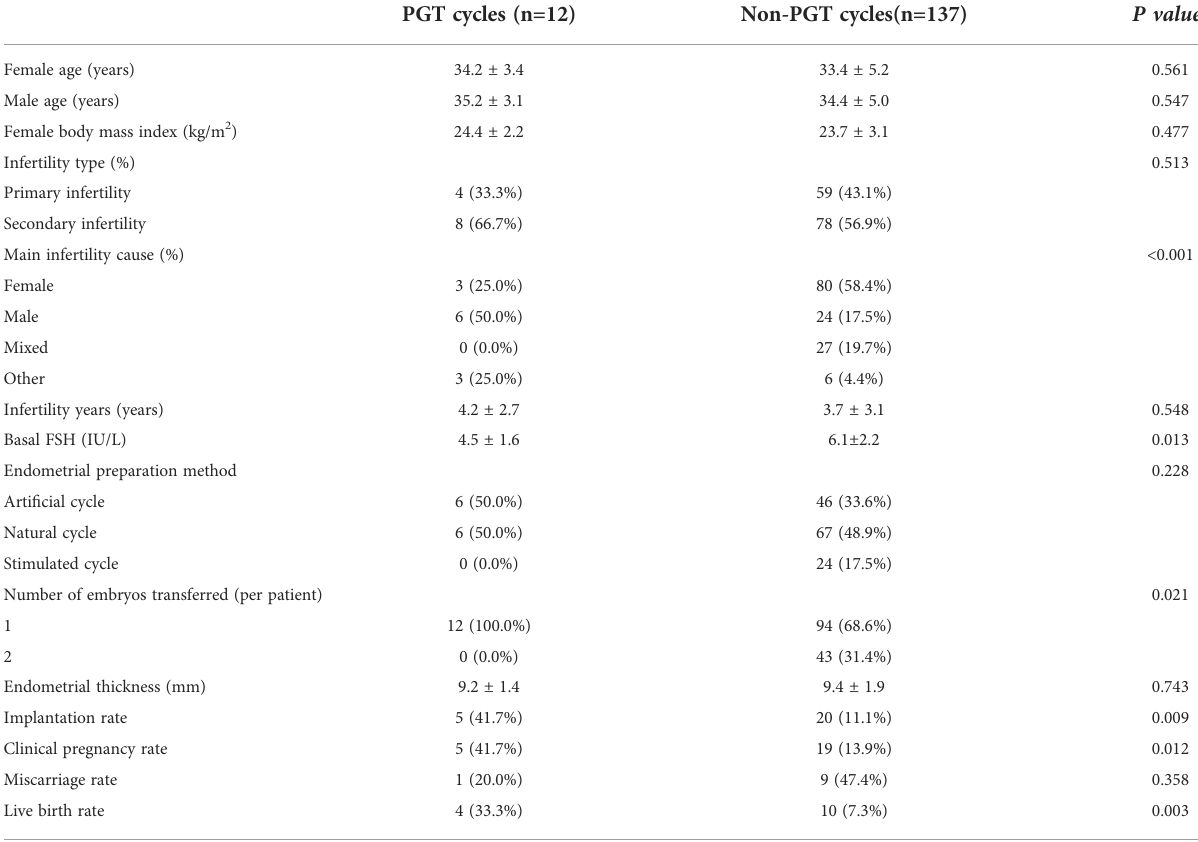
TABLE 2 Basic clinical data and outcomes of FET cycles with D7 blastocysts from different sources.